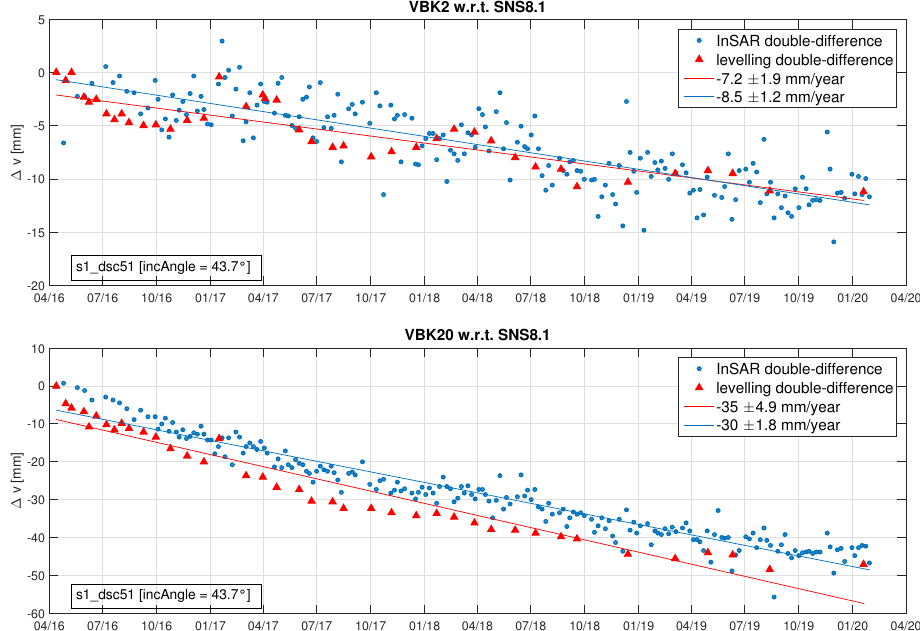
Figure 15. Example of remotIO InSAR vs. leveling double-differenced displacement time series projected to vertical at selected leveling